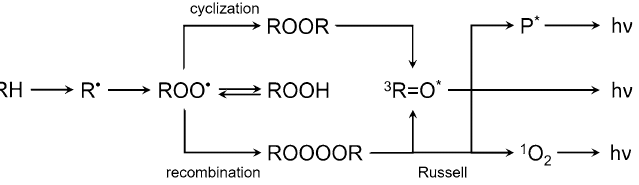
Figure 1. A simplified scheme of reactions of ROS with biological matter and subsequent possible reactions leading to photon emission based on earlier work 9 . Initially, the reaction of ROS with a biomolecule RH leads to the formation of various radicals, which in turn lead to the formation of unstable high-energetic intermediates (ROOR, ROOOOR). Decomposition of these energetic intermediates leads to the formation of electron excited species and subsequent photon emission h ν . See details in the